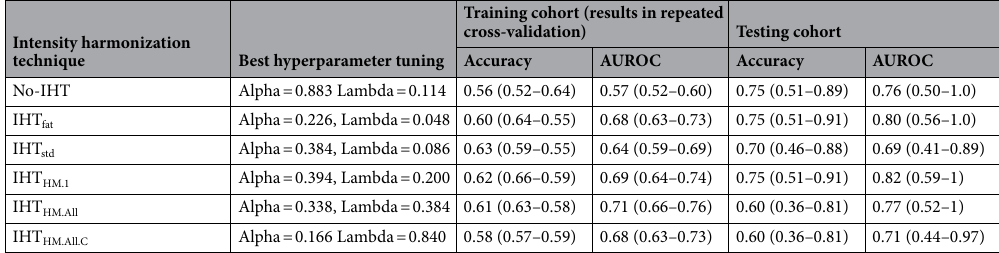
Table 5. Accuracy and area under the ROC curves (AUROC) of the supervised models in repeated cross validation (training cohort) and in the testing/validation independent cohort, depending on the 5 intensity harmonization techniques (IHTs) or the lack of IHT (named No-IHT). Results are giving with 95% confidence